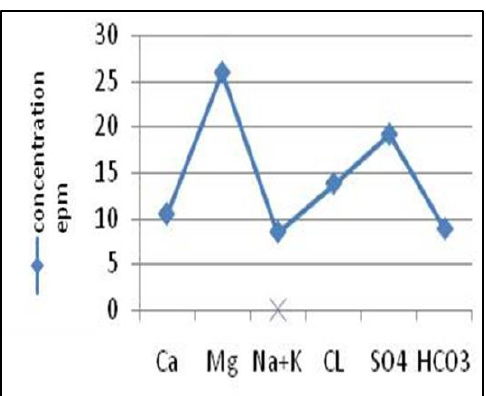
Fig.21: Sholler classification for mean concentrations of ions for High water season in the study